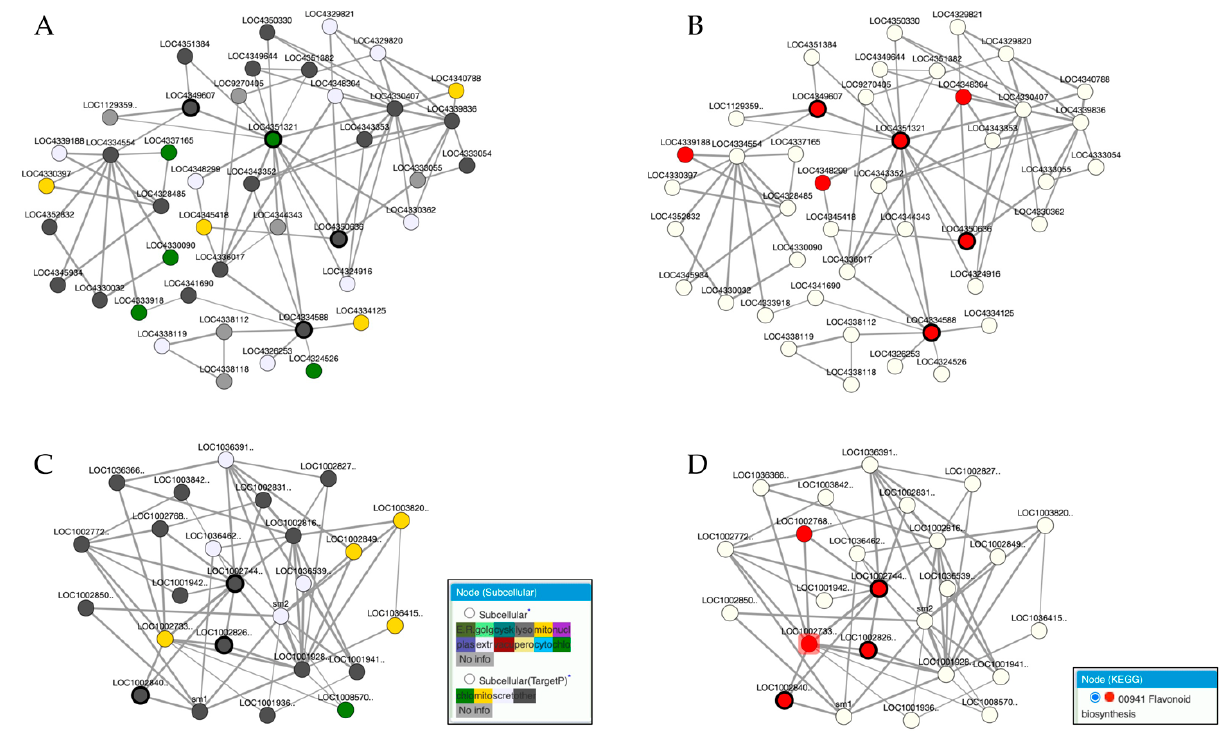
Figure 3. The co-expression network of CHS and CHI genes in rice ( A ) and maize ( C ). ( A ) The nodes with bold lines indicate the query genes for CHS (LOC4350636) and CHI (LOC4351321, LOC4334588, LOC4349607) in rice. ( C ) In maize, the query genes for CHS (LOC100282642, LOC100274415) and CHI (LOC100284018) are also shown with bold lines. ( A , C ) The co-expression network consists of genes classified based on subcellular location, calculated by TargetP. The flavonoid biosynthesis genes were selected based on KEGG in the ATTED-II database, as shown by red nodes in rice ( B ) and maize ( D ). ( D ) The highlighted gene, LOC100273383 was found to be co-expressed with known flavonoid biosynthetic genes (CHS and CHI).